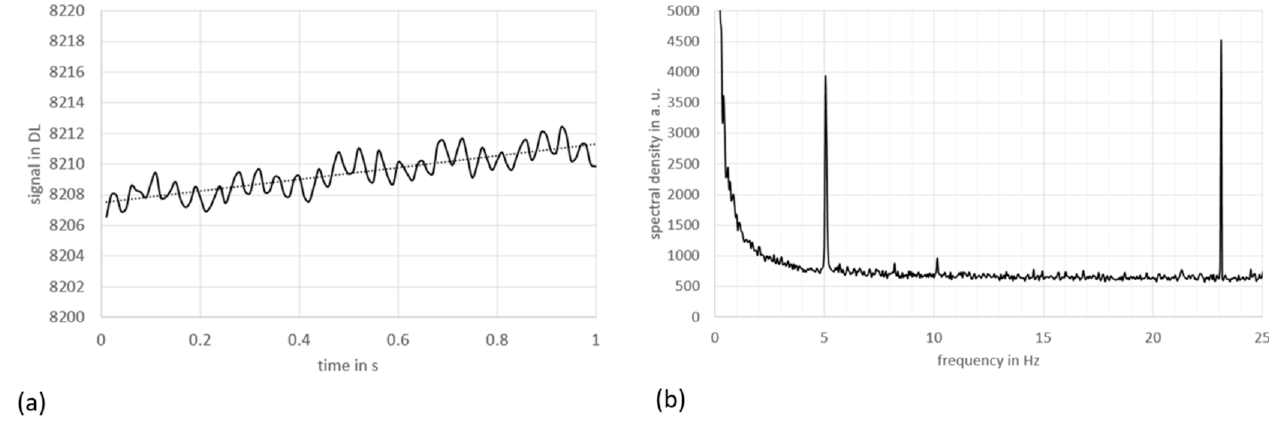
Figure 5. ( a ) Measured temperature signal in digital levels DL as a function of time on the sample surface of the ferromagnetic sample over 1 s of excitation at an induction frequency of 2.5 Hz. ( b ) The corresponding frequency amplitude spectrum obtained for a recording time of 20 s.